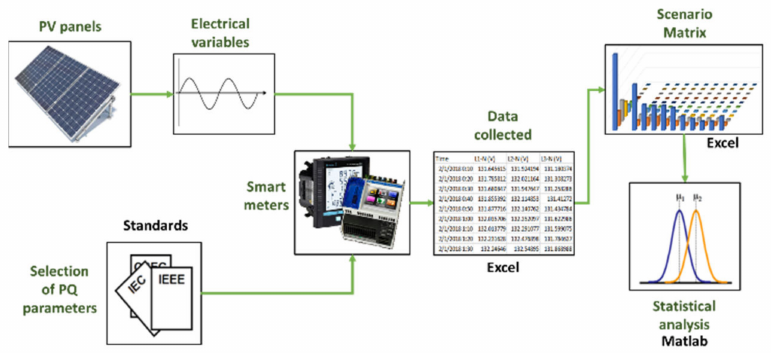
Figure 1. Schematic diagram of methodology proposed by authors